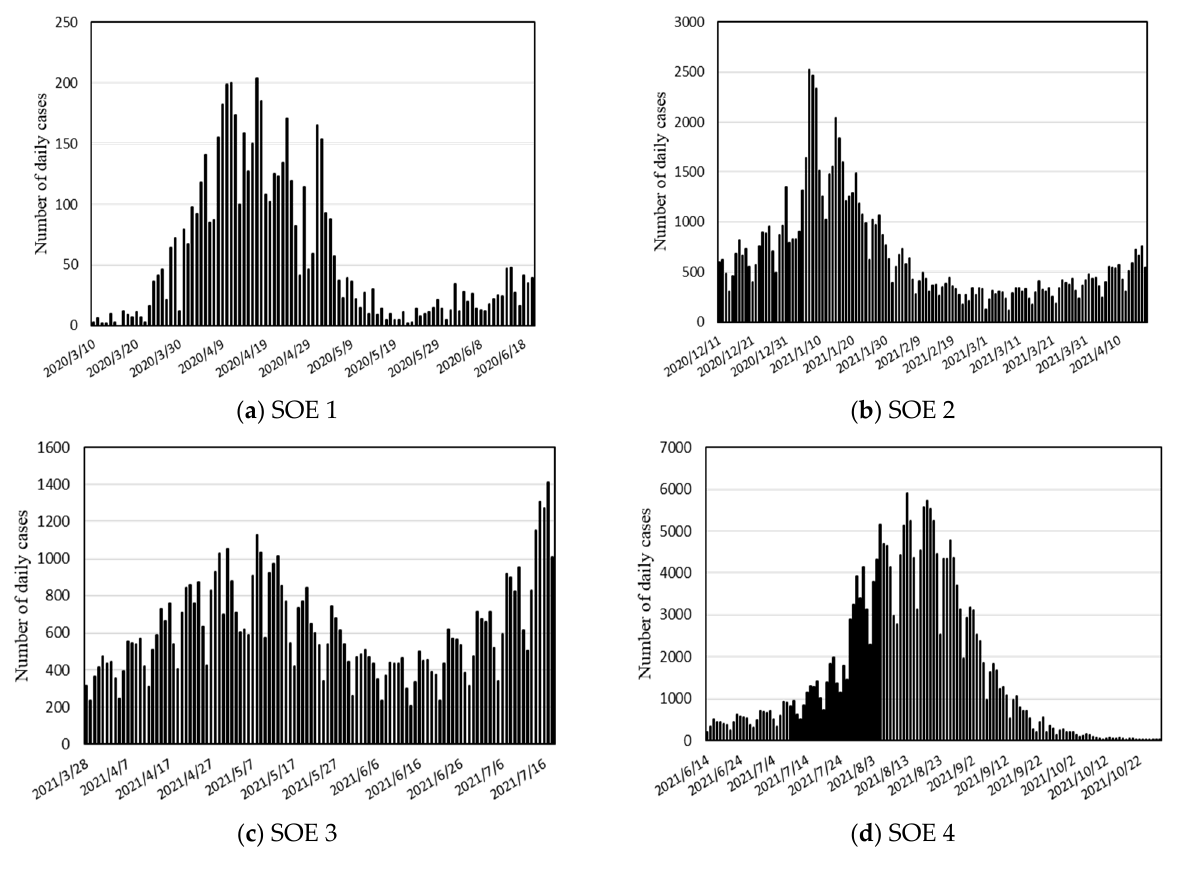
Figure 1. Number of daily COVID-19 cases in Tokyo during the SOE periods. To capture the changes in human mobility during the SOE periods, six mobility indices were obtained from the Google mobility data (Google Inc. 2022). Table 2 describes the details of these mobility indices. Table 2. Descriptions of the human mobility indices.